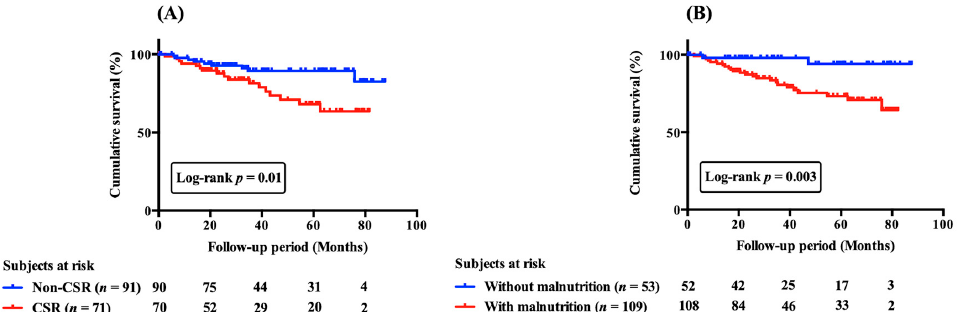
Figure 3. Cumulative survival curves of CSR ( A ) and malnutrition ( B ) on all-cause mortality in patients with acute decompensated heart failure. Cumulative survival curves were significantly different ( A ) between patients with and without CSR and ( B ) between those with and without malnutrition. CSR, Cheyne-stokes respiration.